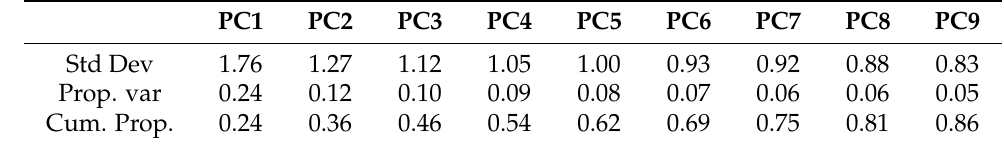
Table 7 lists the PCA summary for the heart disease data. Table 7. % variation explained by each component for the heart disease data.